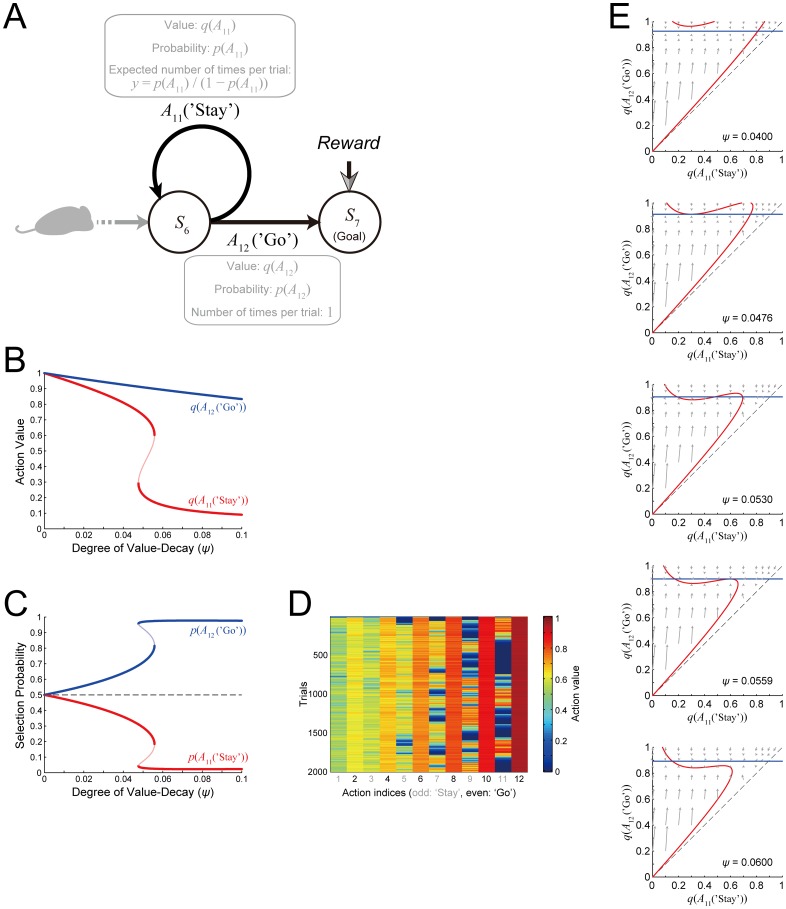
The value-decay generates value-contrasts between ‘Go’ and ‘Stay’.(A) Schematic diagram of the selection of A11 (‘Stay’) and A12 (‘Go’) at S6. We considered a reduced continuous-time dynamical system model that describes the time evolution of q(A11) and q(A12), which are continuous-time variables approximately representing the action values of A11 (‘Stay’) and A12 (‘Go’), respectively. (B) Bifurcation diagram of the reduced model, showing the equilibrium values of q(A11(‘Stay’)) (red line) and q(A12(‘Go’)) (blue line) (vertical axis) depending on the degree of the value-decay (horizontal axis; ψ = 0 corresponds to the case without the value-decay). Temporal discounting was not assumed. The thick parts of the lines indicate the stable equilibriums, whereas the thin part indicates the unstable equilibrium; the unstable equilibrium of q(A12(‘Go’)) is overlapped by the stable equilibrium and is thus invisible. (C) Probability of selecting A11 (‘Stay’) (red) or A12(‘Go’) (blue) at the equilibriums (vertical axis) depending on the degree of the value-decay (horizontal axis). The thick parts and thin parts correspond to the stable and unstable equilibriums, respectively. (D) A simulation result of the original model with the decay rate φ = 0.0045, in which there appears a phenomenon indicative of bistability: the value of A11 (‘Stay’) fluctuates between two levels in long time scales. (E) Phase diagrams in the cases with five different degrees of the value-decay. The red and blue lines indicate the nullclines on which the time derivative of q(A11(‘Stay’)) or q(A12(‘Go’)) is zero, respectively. The gray arrows indicate the direction of the time evolution of q(A11(‘Stay’)) and q(A12(‘Go’)) (indicating vectors (dq(A11)/dt, dq(A12)/dt)/2). Notably, the analysis of the reduced model was conducted under the assumption of q(A11(‘Stay’)) ≤ q(A12(‘Go’)), which corresponds to the upper left region of the black dashed line.